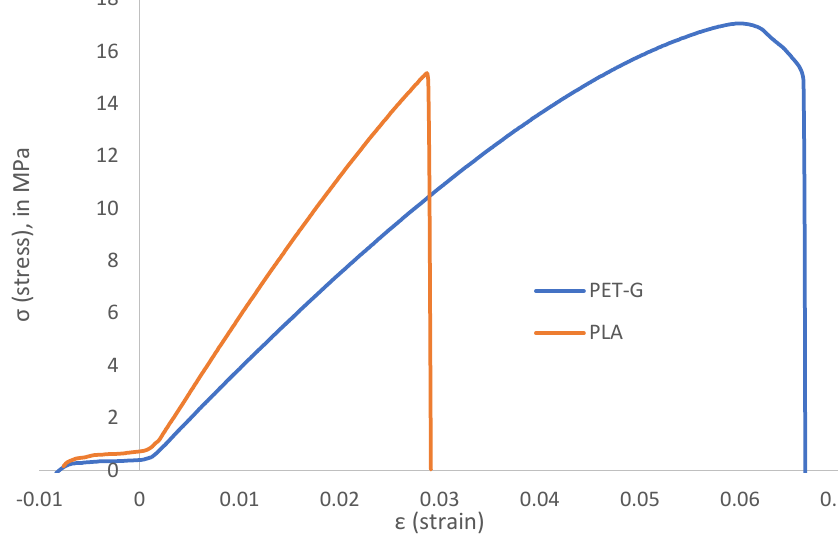
Figure 7. Comparison between PLA and PET-G raw elongation data for specimen 7 (set 3).